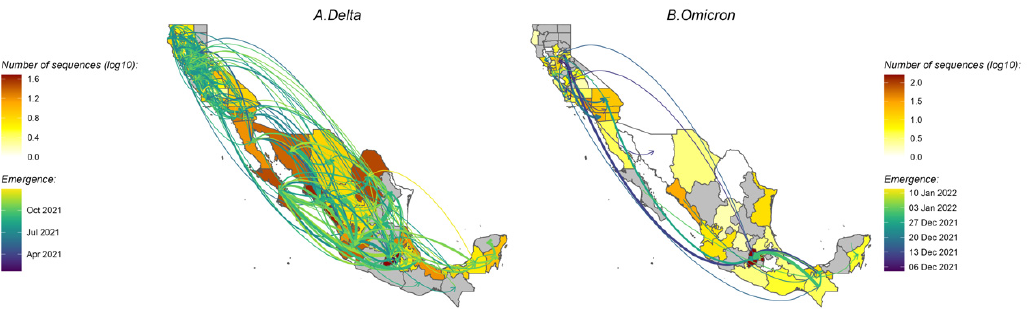
Figure 3. Map of migration events between locations for Delta ( A ) and Omicron ( B ) variants. The thickness of the arrows reflects the average number of inferred transmission events between locations and the colors of the arrows indicate the timing of the transmission event. California counties and Mexico states are colored according to the number of sequences. All 10 replicates are combined to show the timing of the introductions of the clades in the region. See also Supplementary Figure S6 for the results of each of the 10 replicates. Only the migration events with strong support (BF ≥ 20) are shown.